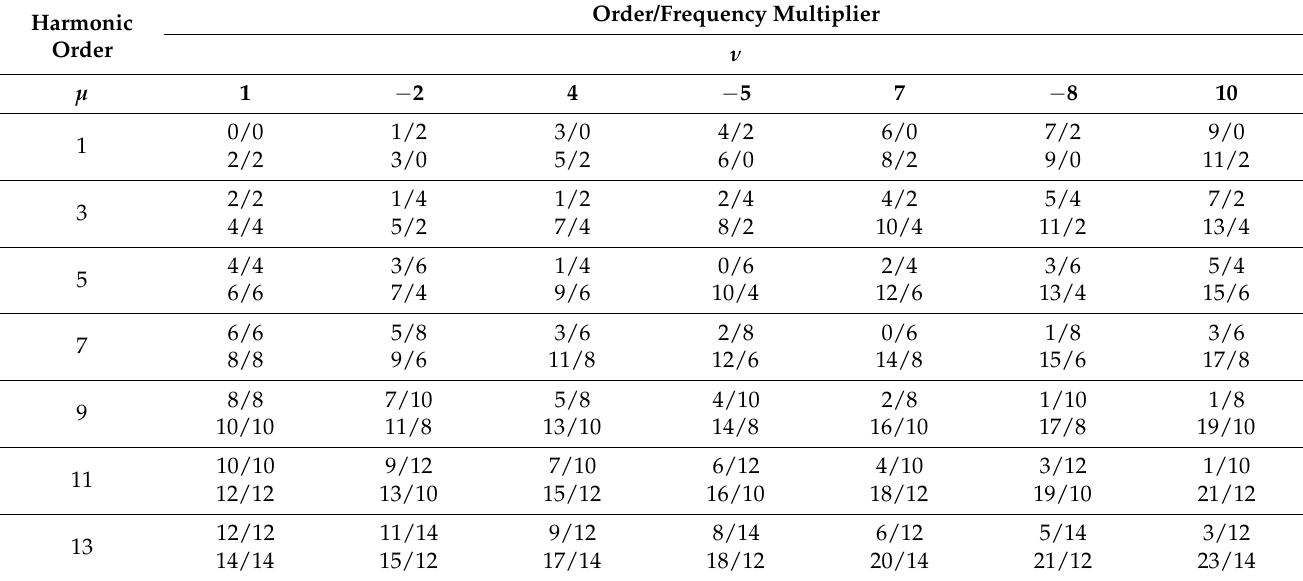
Table 5. PM field and stator magnetic field produce radial electromagnetic